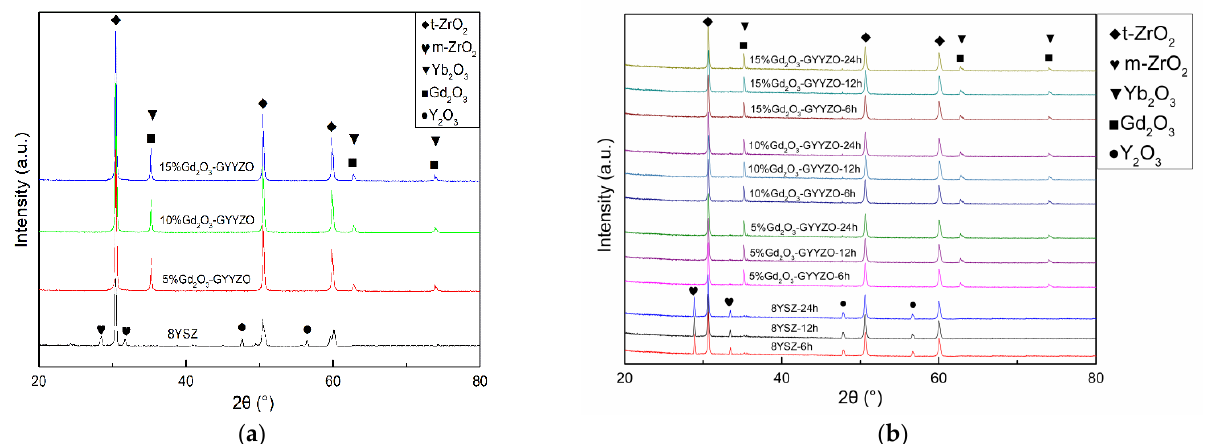
Figure 3. XRD analysis of powder and bulk materials: ( a ) powder; ( b ) bulk materials.